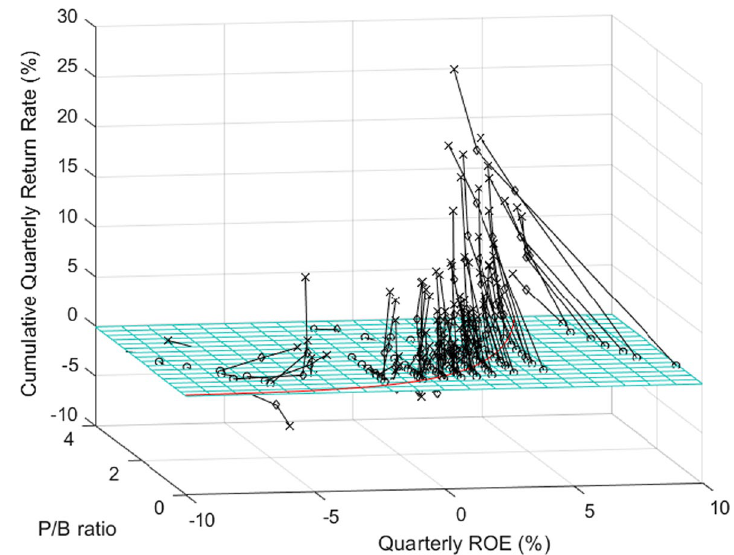
Fig. 24 The relationship among ROE, P/B, and cumulative quarterly return rates (circle, diamond, x‑mark: the data in the t, t 1, t 2 Quarter) + +